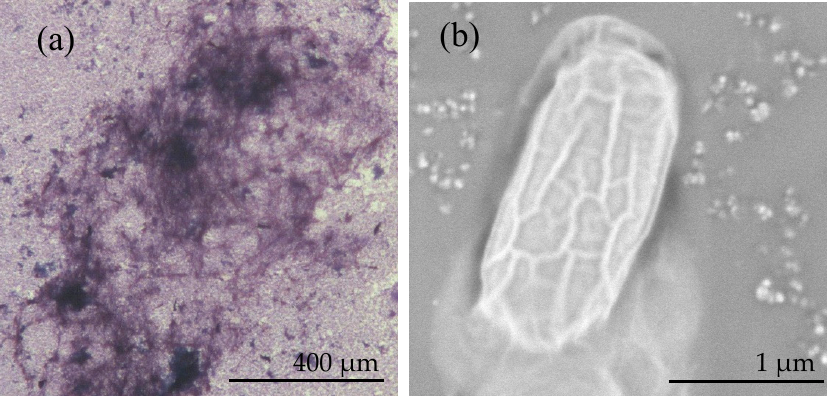
Figure 2. B. licheniformis analyzed by microscopy and SEM. ( a ) The Gram stain in biological microscope view; ( b ) the morphology in SEM view.